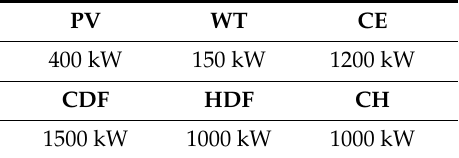
Table 1. The rated capacity of each device in MEG.